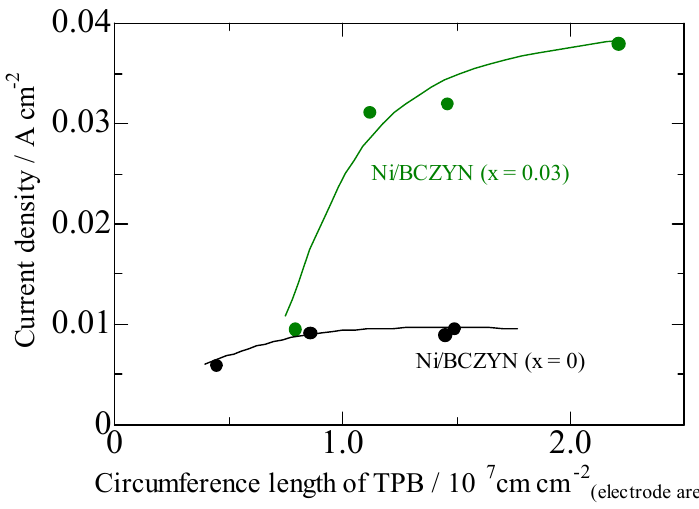
Figure 5. Current density at η = − 0.1 V as a function of circumference length of triple phase boundary (TPB) at 700 °C.